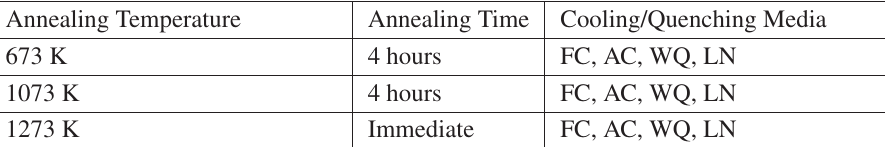
Table 2. The heat treatments and cooling rates applied to the low-carbon microalloyed steels.